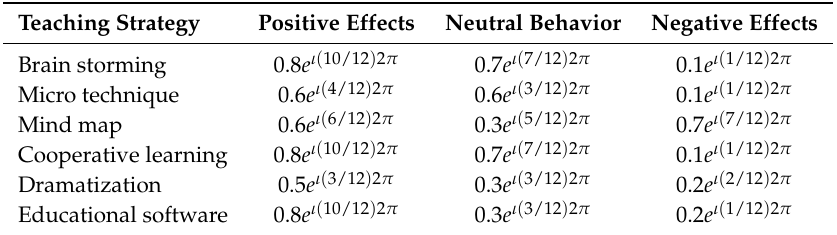
Table 6. Impacts of modern teaching strategies.